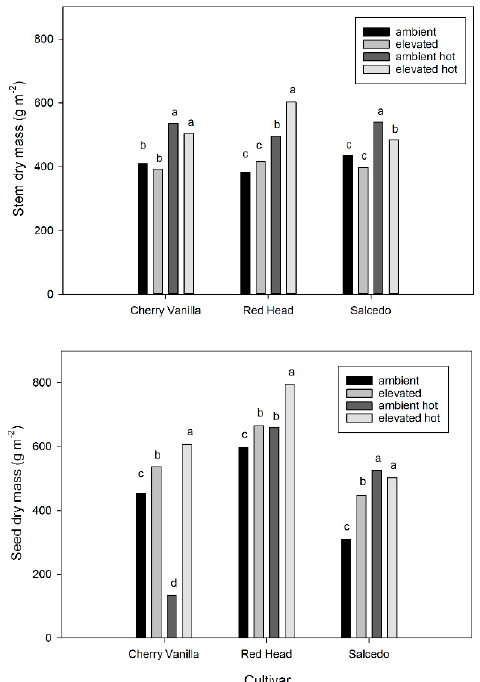
Figure 1. Stem and seed dry mass responses of three cultivars of quinoa to ambient (400 μ mol·mol − 1 ) or elevated (600 μ mol·mol − 1 ) CO 2 concentrations, with or without a high temperature treatment for 7 days beginning at anthesis. The control growth day/night temperatures were 20/14 °C, and the high temperature treatment was 35/29 °C. Within cultivars, different letters indicate significant differences in mean values, based on analysis of variance (ANOVA). Table 1. Photosynthesis (in μ mol CO 2 m − 2 ·s − 1 ) of upper leaves of three cultivars of quinoa grown at